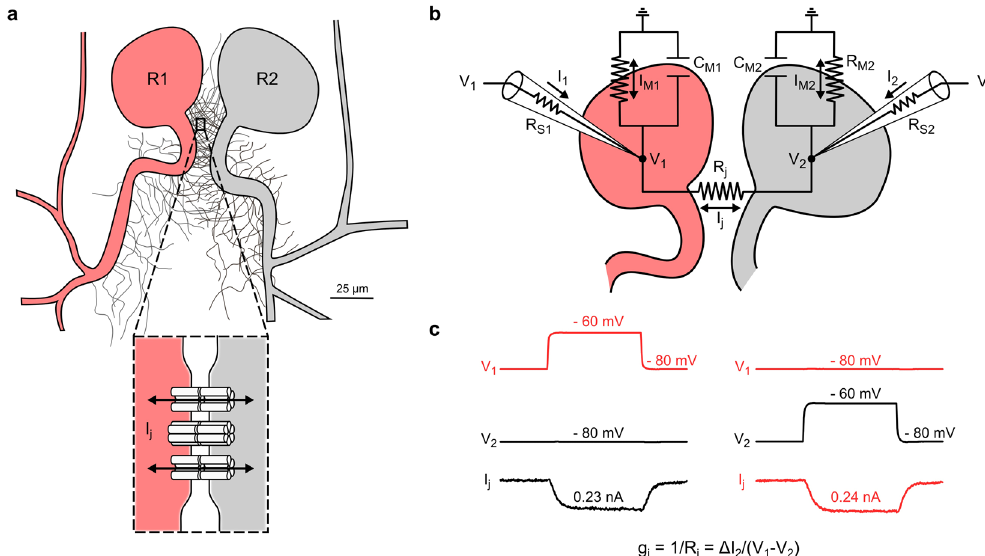
Figure 1. Direct measurement of gap junctional currents between electrically coupled Retzius cells. ( a ) Schematic representation of the somata and the neurites emerging from the primary axons of a pair of Retzius neurons (R1 and R2) in the leech nervous system (adapted from García-Pérez 34 ). The somata are electrically coupled by non-rectifying electrical synapses (see inset) between pairs of neurites within the neuropilar arborizations proximal to the soma 34 , where application of voltage-clamp protocols was directly confirmed (Fig. S1). ( b ) Equivalent circuit of the electrically coupled R cells with recording microelectrodes (15–30 M Ω resistance). R S1 , R S2 : series resistances of microelectrodes. V 1 , V 2 : membrane potentials of R1 and R2. Cell membranes with resistances R M1 , R M2 and capacities C M1 , C M2 . R j : gap junctional resistance. I j : gap junctional current. I 1 , I 2 : currents sent through microelectrodes. I M1 , I M2 : currents across membrane resistances. ( c ) To measure junctional currents, two coupled single-electrode voltage-clamp amplifiers clamped the cells